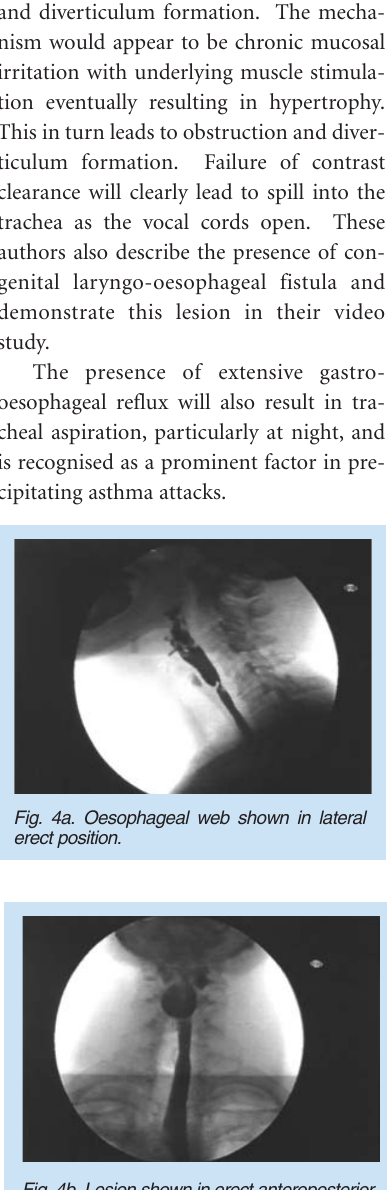
Fig. 4b. Lesion shown in erect anteroposterior